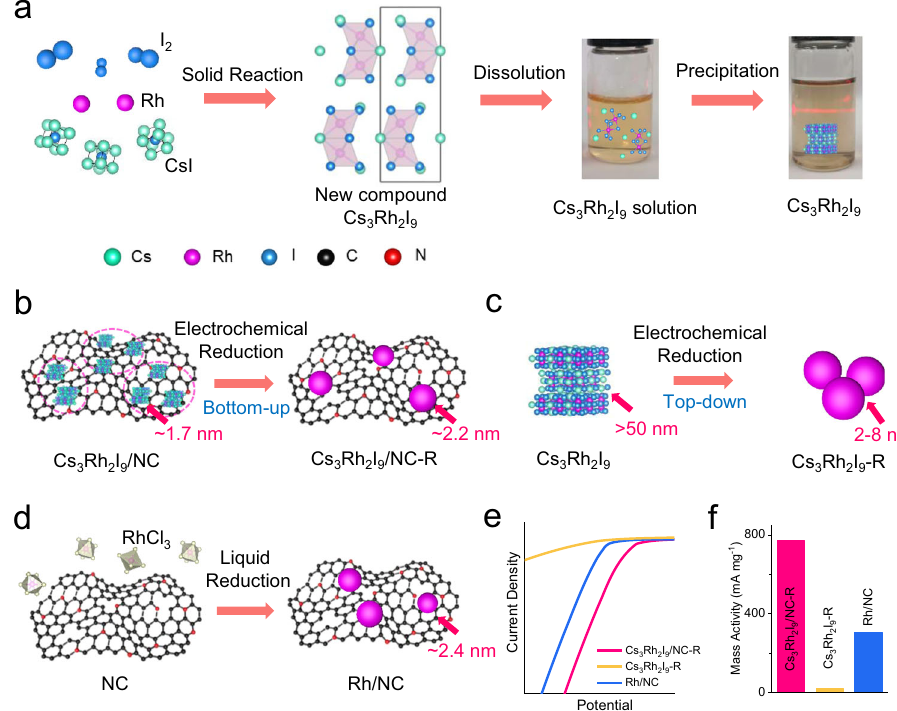
Fig. 1 | Schematic illustrationofsynthesizing perovskiteCs 3 Rh 2 I 9 bulkcrystals andclustersCs 3 Rh 2 I 9 /NC,andtheirelectrochemicalreductionintometallicRh particles toward alkaline HER. a Synthesis of Cs 3 Rh 2 I 9 bulk crystal via a solid reaction using I 2 , Rh, and CsI at 800 o C. The Cs 3 Rh 2 I 9 crystal could demonstrate a dissolution-precipitation phenomenon in N, N-dimethylformamide (DMF). b Electrochemical reduction of Cs 3 Rh 2 I 9 clusters (~1.7nm) supported on NC (Cs 3 Rh 2 I 9 /NC)toformCs 3 Rh 2 I 9 /NC-Rwithalittlelargersize(~2.2nm)viaabottom-